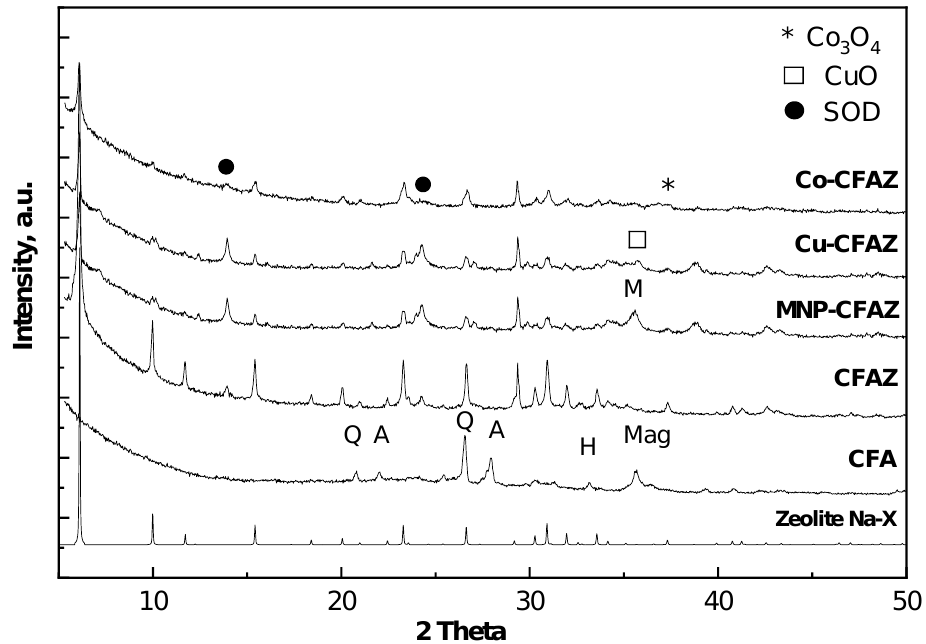
Figure 1. Experimental X-ray di ff raction patterns of a nanocrystalline zeolite of Na-X type (CFAZ) and modified CFAZ: Q—quartz, A—anorthite, H—hematite, Mag—magnetite, M—maghemite. A referent X-ray di ff ractogram of zeolite Na-X is plotted for